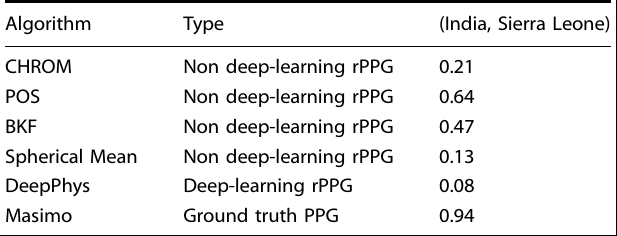
Table 2. KS test — p value comparison with respect to gender. Table 3. Results ( p values) for hypothesis tests conducted across subjects of India and Sierra Leone for different rPPG approaches (test 15), compared to